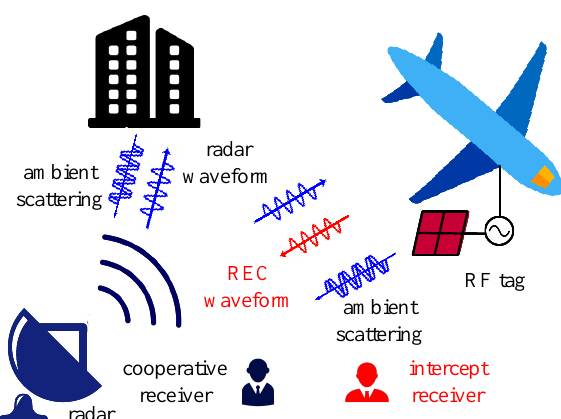
Figure 1. Generic radar-embedded communication (REC)